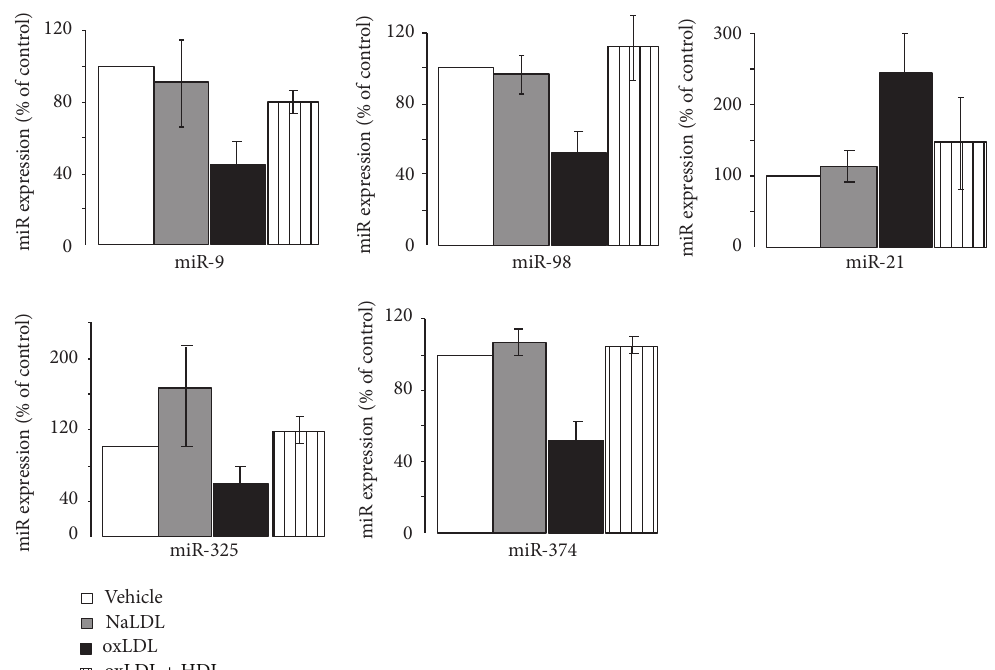
Figure 2: Identification of miRNAs differentially expressed in MIN6 cells cultured with human native and oxidized LDL. The expression of the indicated miRNAs was measured by quantitative RT-PCR in MIN6 cells that were cultured with vehicle, 2 mmol/L of oxidized LDL (oxLDL), and native LDL (NaLDL), plus or minus 1mmol/L HDL-cholesterol for 72 hrs. Human plasma LDL and HDL fractions were isolated by sequential ultracentrifugation (LDL density, 1.063) as described [95]. Oxidation of LDL particles was done by incubation of 1mg LDL protein/mL PBS with 5 𝜇 mol/L CuSO4 at 37 ∘ C for 6–8 h [95]. The oxidation reaction was verified as previously described by determining the lipid peroxide content [95]. The results are expressed as fold changes and correspond to the mean ±